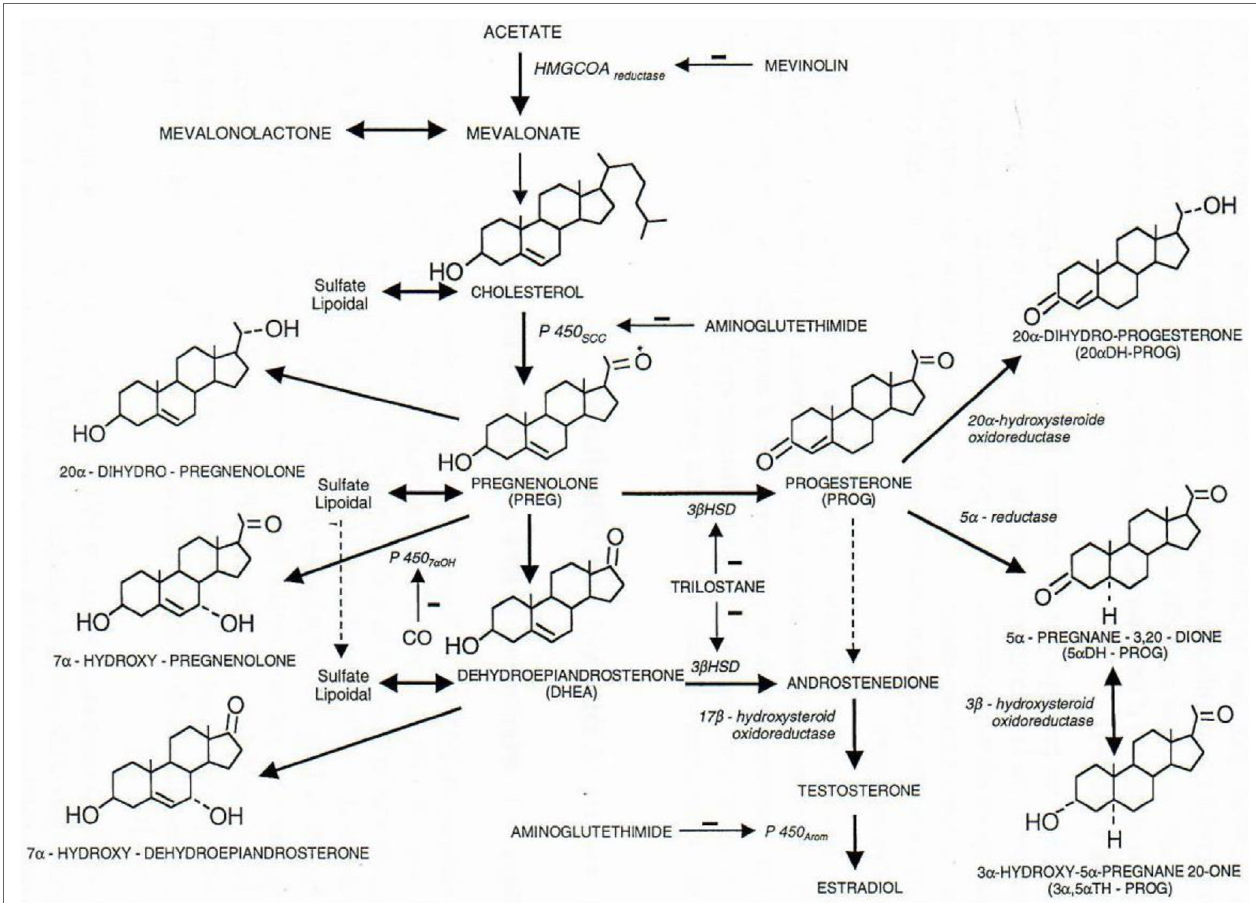
FIGURE 1 | Some metabolic pathways of physiological steroids. All steroids are cholesterol derivatives. The P450scc cytochrome (scc for side chain cleavage) cut the 6 carbon chain of cholesterol, and pregnenolone thus synthetized is precursor of all steroid hormones (3 β -HSD, 3 β -hydroxysteroid dehydrogenase; 3 α -HSOR, 3 α -hydroxysteroid oxidoreductase; 17 β -HSOR, 17 β -hydroxysteroid oxidoreductase). Negative signs ( − ) indicate the lack of the enzymatic function corresponding to the indicated product. Figure from Baulieu